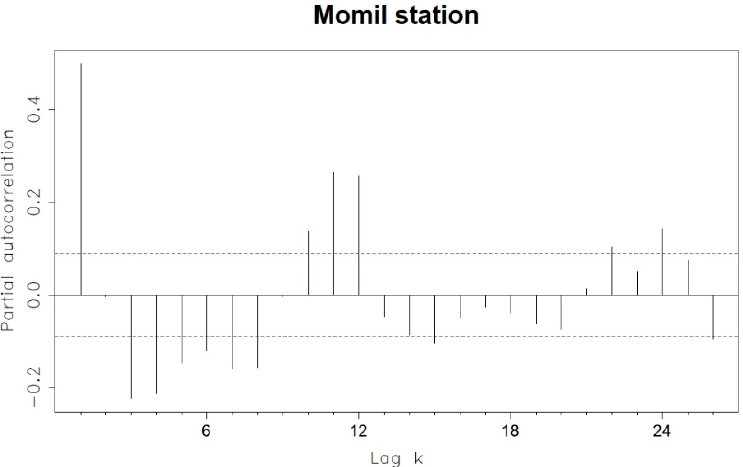
Figure 7. Partial autocorrelation function (PACF) of the calibration vector of the transformed precipitation time series using